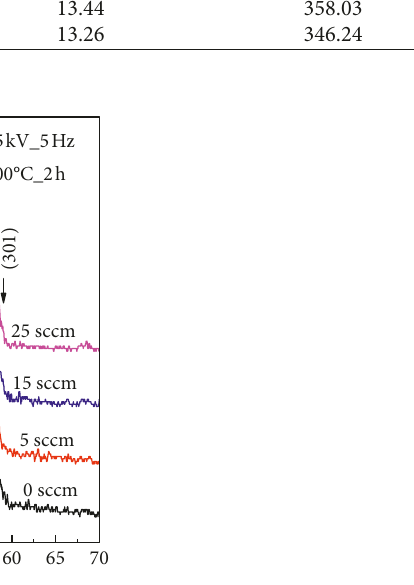
Table 3: The lattice parameters of the LaMnO Sample